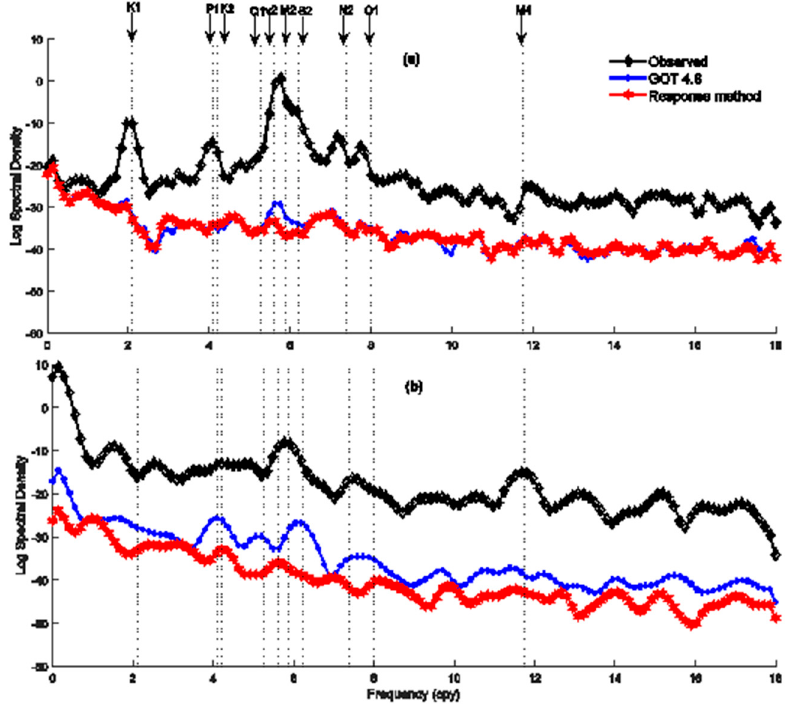
Figure 10. PSD profiles of observed and de-tided SLAs (after removing tides) as examples of tidal prediction in ( a ) deep ocean and ( b ) shallow-water areas. Points are located at 122°7 ′ 54.84 ″ E, 17°45 ′ 42.84 ″ S ( a ), and 121°25 ′ 53.04 ″ E, 16°0 ′ 50.40 ″ S ( b ). Scales are identical in both graphs.